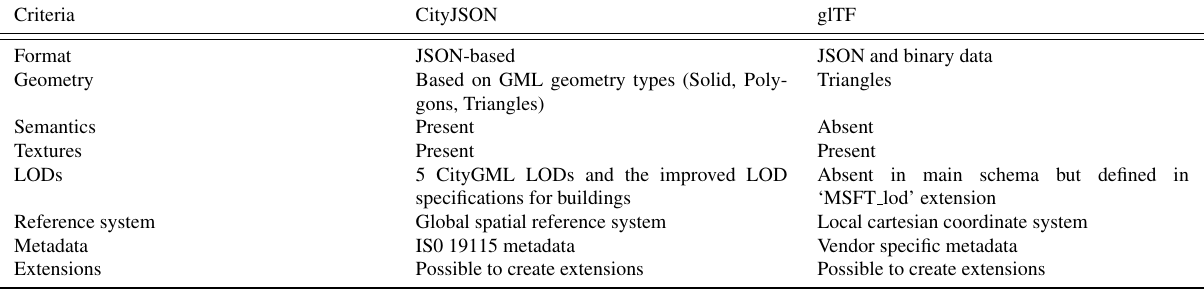
Table 1: Comparison of CityJSON & glTF